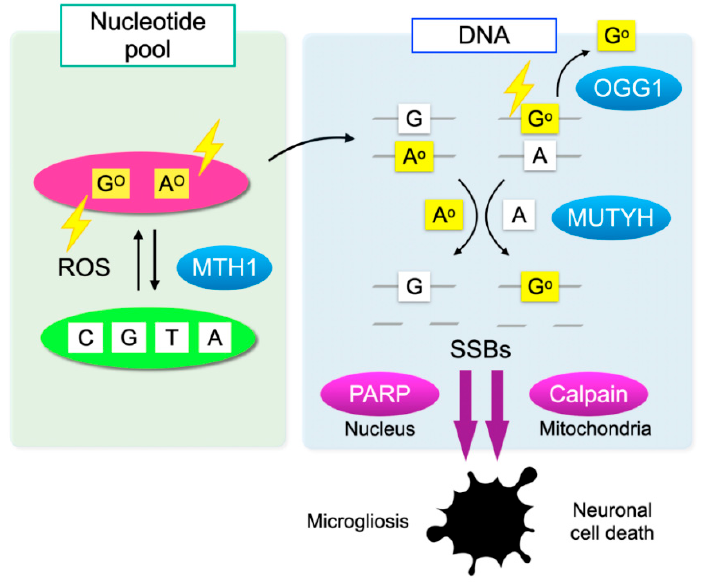
Figure 3. Oxidative DNA damage and its repair system. Oxidation of DNA occurs via two processes: one is the direct oxidation by reactive oxygen species (ROS) and the other is the incorporation of oxidized bases from the nucleotide pool. Oxidative insults are shown in lightning symbols. During DNA replication, 8-oxoG can mispair with adenine, resulting in the formation of somatic mutations. Mut T homolog-1 (MTH1) hydrolyzes oxidized purine nucleoside triphosphates, such as 8-oxo-7,8-dihydrro-2 ′ -deoxyguanosine 5 ′ -triphosphate (8-oxo-dGTP) and 1,2-dihydro-2-oxo-2 ′ -deoxyadenosine 5 ′ -triphosphate (2-oxo-dATP) in the nucleotide pool, thereby preventing the incorporation of oxidized nucleotides into DNA. On the one hand, 8-oxoG in DNA is excised by 8-oxoguanine DNA glycosylase-1 (OGG1). On the other hand, the Mut Y homolog (MUTYH) excises the mismatched adenine opposite 8-oxoG, and 2-oxoA opposite guanine. MUTYH can suppress mutagenesis caused by oxidative DNA damage; however, under severe oxidative DNA damage, MUTYH-mediated BER leads to accumulation of single-strand breaks (SSBs) in DNA. SSBs in the nuclear DNA activates poly(ADP-ribose) polymerase (PARP) and SSBs in mitochondrial DNA results in calpain activation through mitochondrial dysfunction, which in turn induces microgliosis and neuronal cell death during neurodegeneration, respectively.